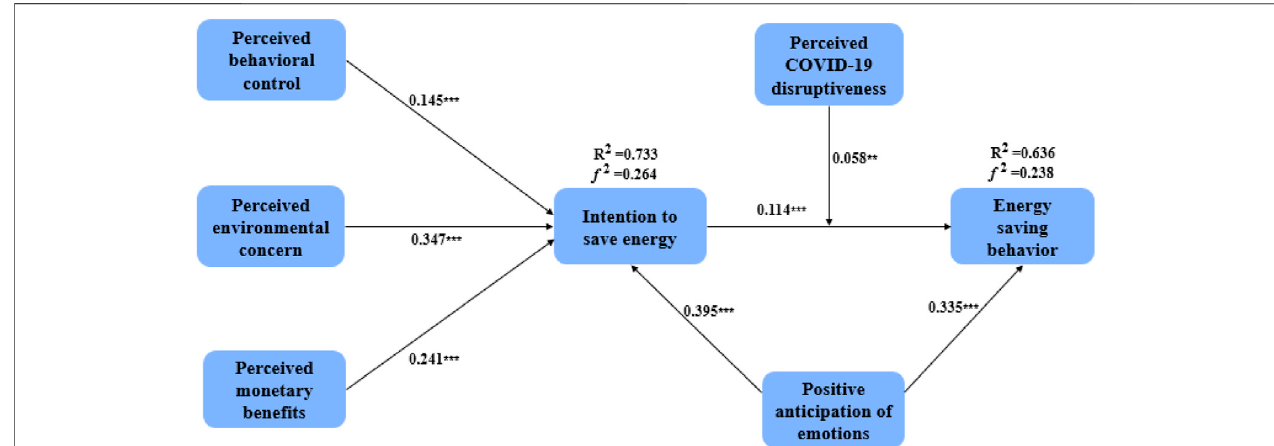
FIGURE 2 | Results of